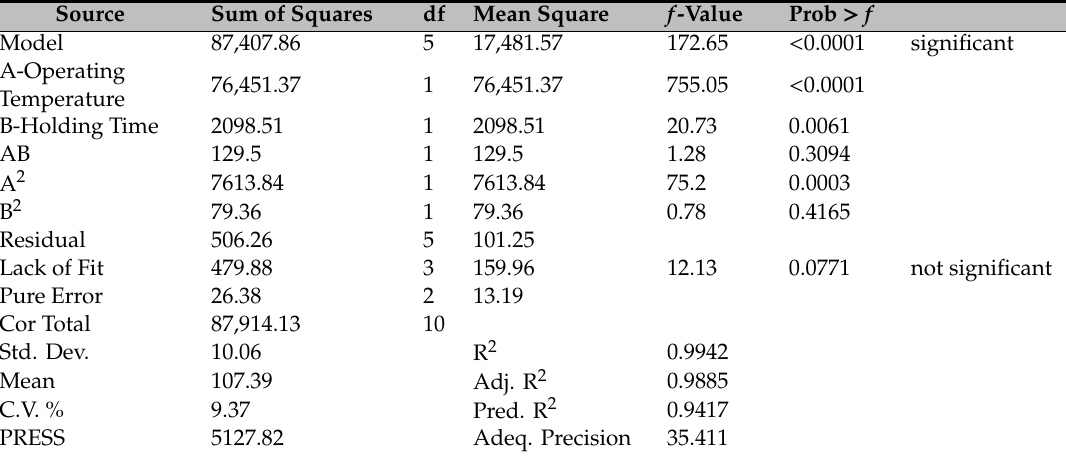
Table 7. ANOVA table for ultimate tensile strength,